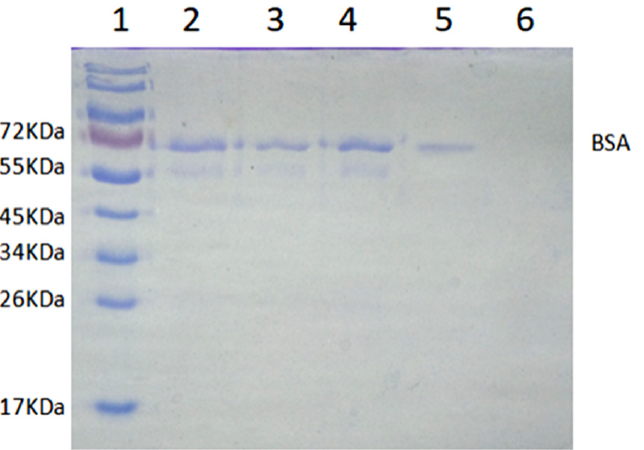
Figure 11. The SDS-PAGE analysis of isolating BSA from calf serum by solid-phase extraction: Lane 1, 10 µ L of protein molecular weight marker; lane 2, 10 µ L of 100-fold dilution of calf serum solution before adsorption; lane 3, 10 µ L of 100-fold dilution calf serum solution after adsorption with the MICM; lane 4, 10 µ L of calf serum solution after adsorption with the NMICM; lane 5, 10 µ L of the recovery solution from MICM; lane 6, 10 µ L of the recovery solution from NMICM.